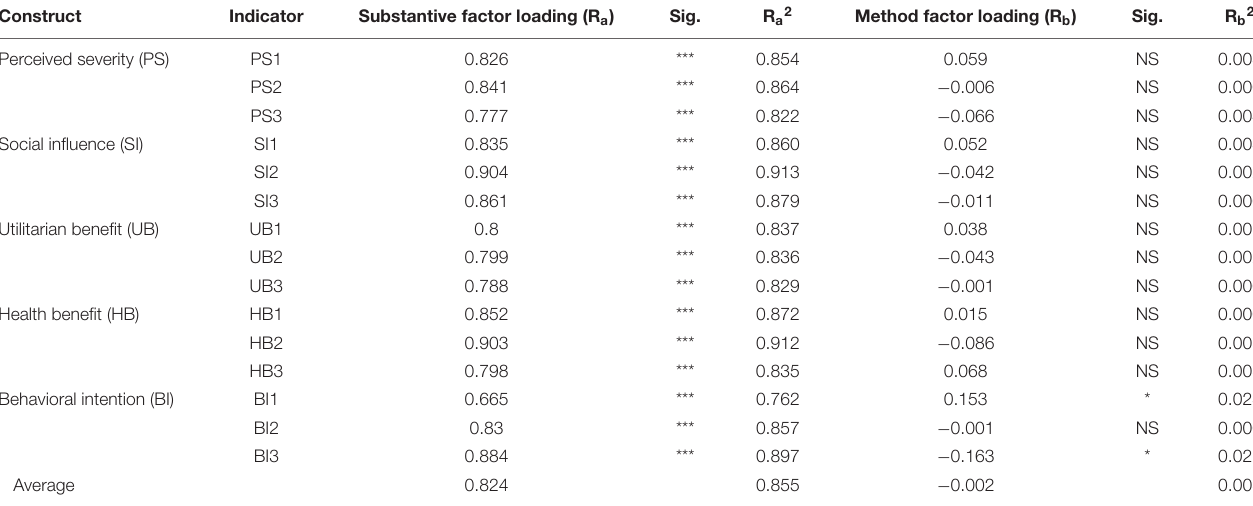
TABLE 3 | Common method factor analysis.